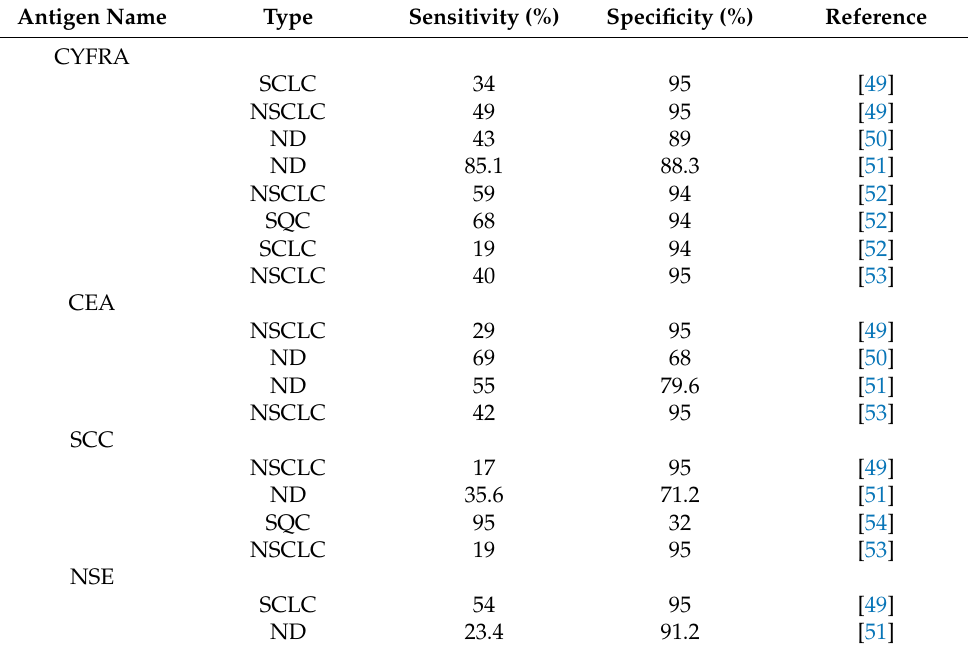
Table 2. Sensitivity and specificity analysis of common antigens found in lung